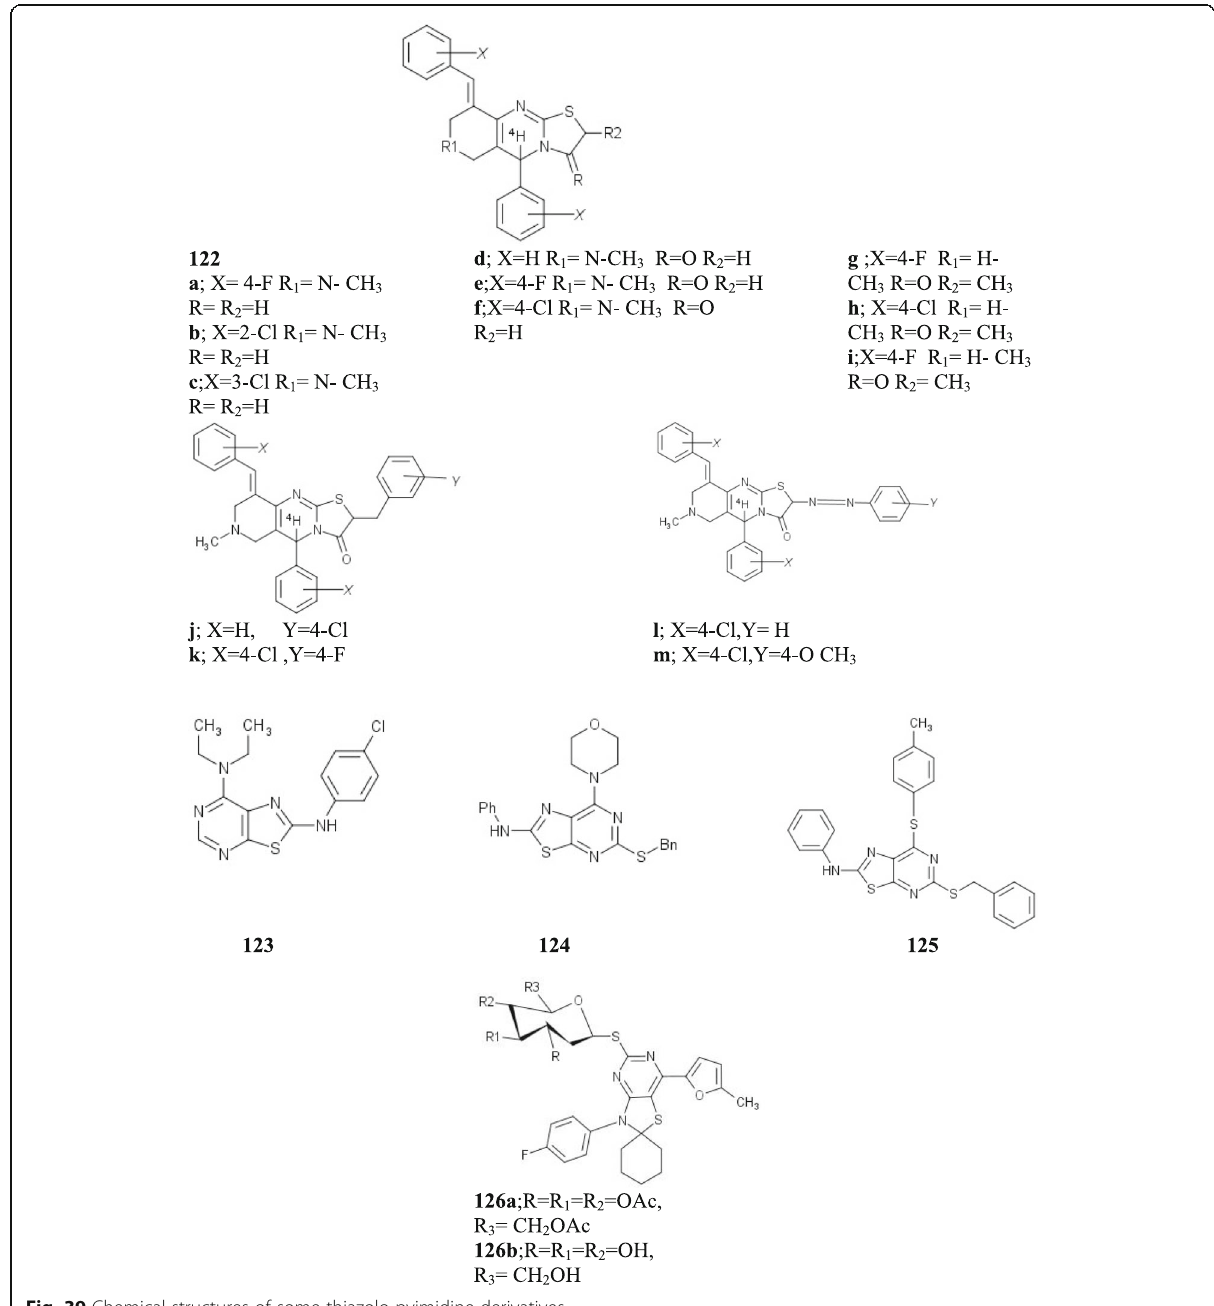
Fig. 39 Chemical structures of some thiazolo pyimidine